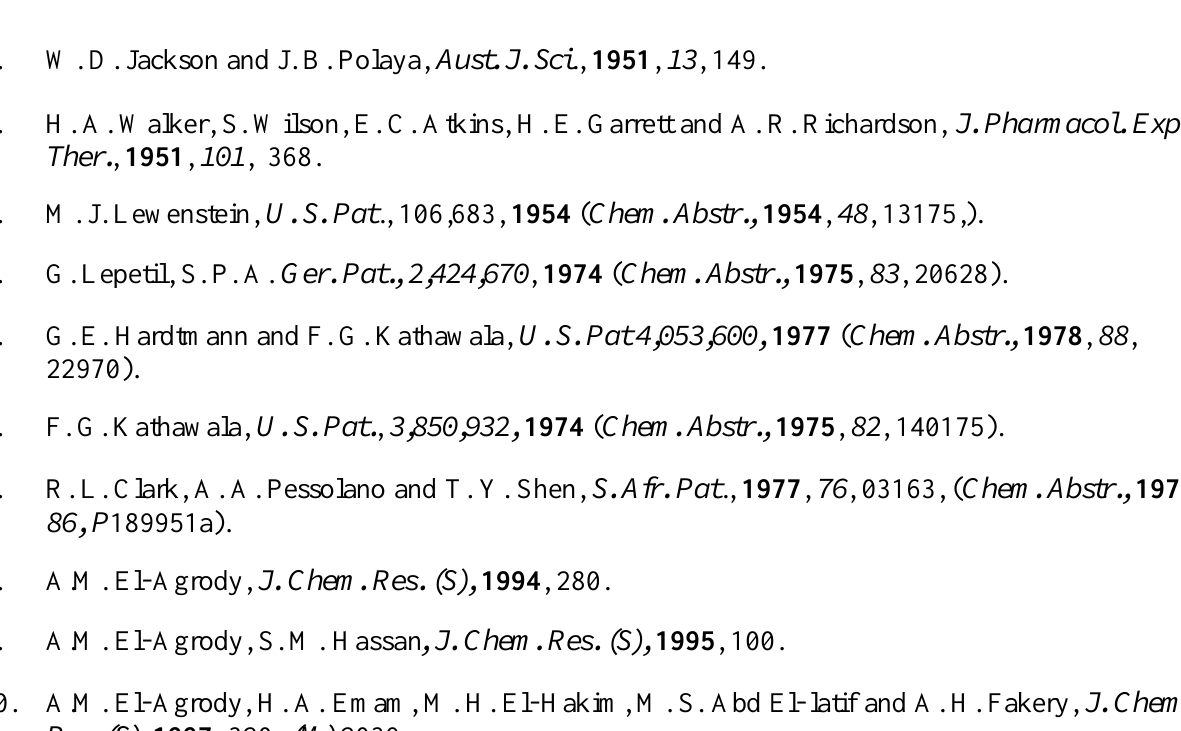
Elemental analyses Found (Required)